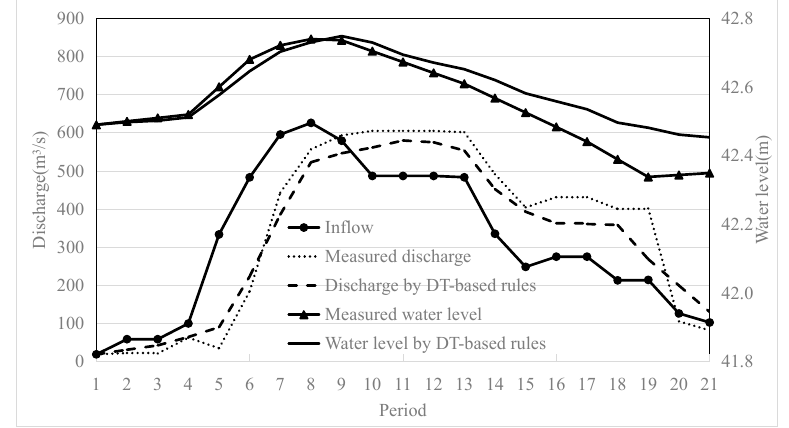
Figure 4. Operation hydrographs for 22 July 2020.